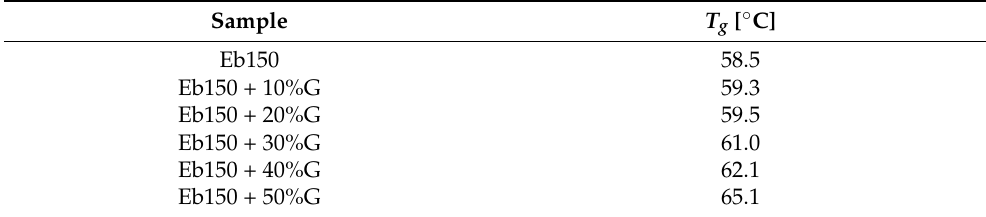
Table 1. Glass transition temperatures of UV-LED cured